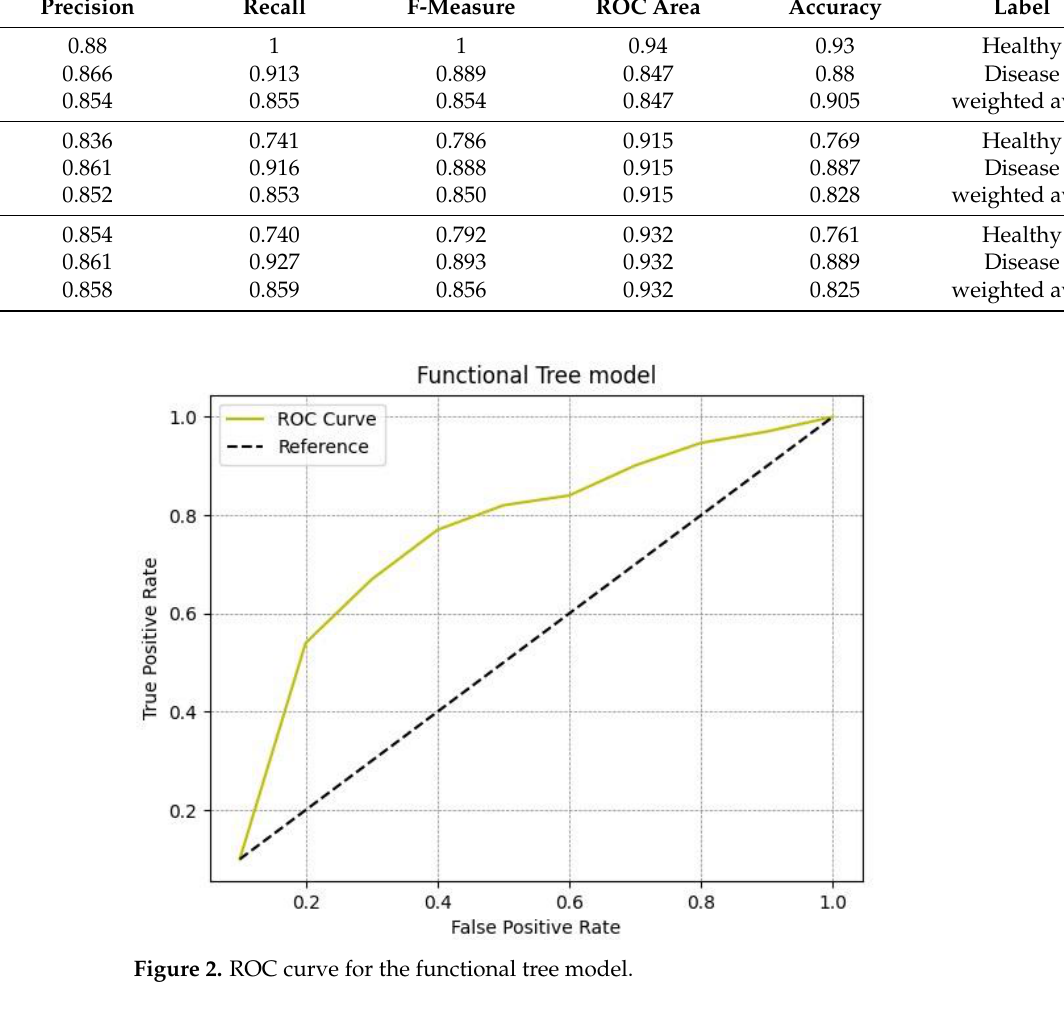
Figure 3. — ROC curve for the Rep Tree model.